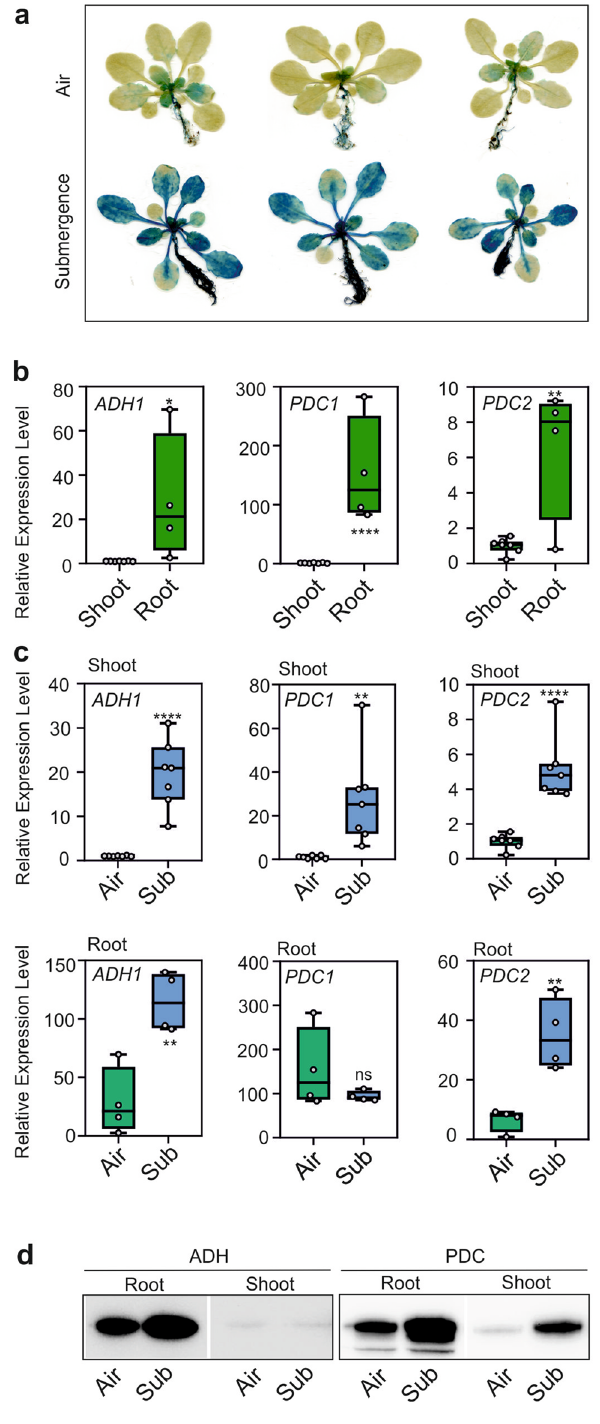
Figure 8. Expression of ADH1 , PDC1 , and PDC2 in aerobic and submerged Arabidopsis plants. ( a ) GUS staining of pADH1:GUS plants in air or 35 h submergence. ( b ) Comparison of the expression (RT-qPCR) of ADH1 and PDC1 in roots and shoots of aerobic plants. ( c ) Comparison of the expression (RT-qPCR) of ADH1 , PDC1 and PDC2 in air (green box) vs. 35 h submergence (Sub, blue box). Lines in the boxes indicate the median. The bottom and top of each box denote the first and third quartile, respectively. The dots represent the single data points and whiskers denote the min/max values. Statistically significant differences are indicated by an asterisk (T-test, pairwise comparison at each time point, * = p < 0.05; ** = p < 0.01; *** = p < 0.001; **** = p < 0.0001). ( d ) Immunoblot analysis of proteins in aerobic and submerged plants. Equal loading was verified by protein staining (Figure